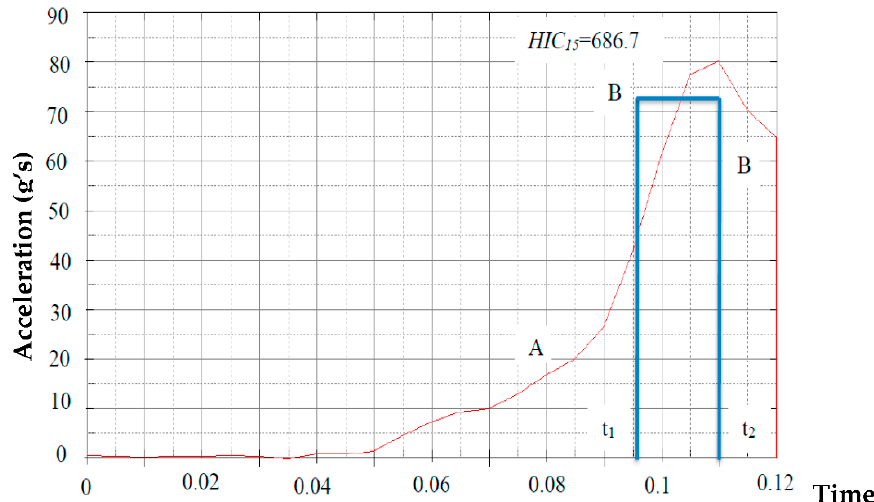
Figure 9. Acceleration and HIC 15 value of the dummy head: ( A ) Dummy head acceleration behavior; ( B ) Interval where the highest deceleration is present use to determine HIC parameter. The red line (A) in Figure 9 represents the head dummy behavior, and the blue line is the HIC 15 parameter, which has a value of 686.7 over interval t 1 = 91.84 and t 2 =